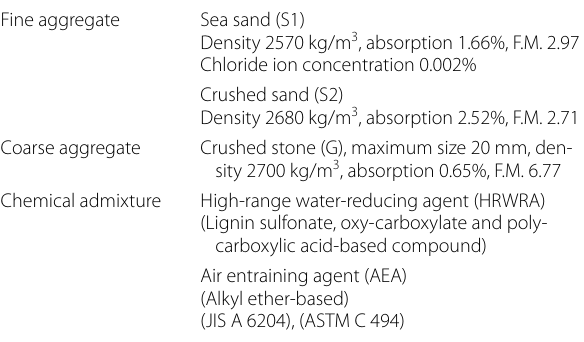
Table 2 Properties of aggregates and chemical admixture.